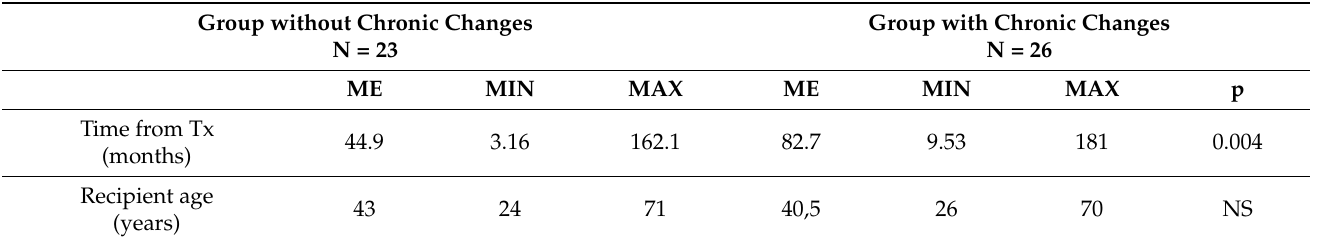
Table 3. Characteristics of the groups: with and without chronic changes in allograft biopsy